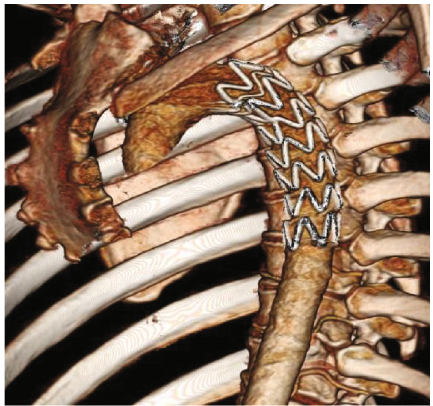
Figure 4: Postoperative CT image reconstruction demonstrating graft location and the successful occlusion of the